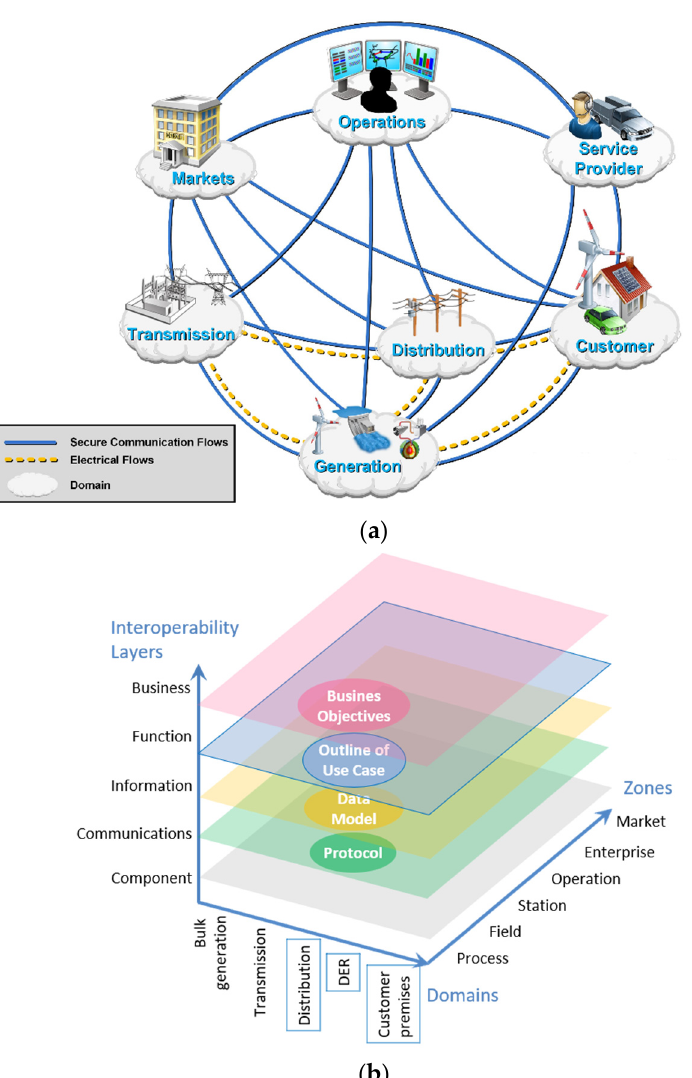
Figure 2. ( a ) NIST smart grids conceptual model with conceptual domains [18]. ( b ) Smart grid architecture model, adapted from [16].